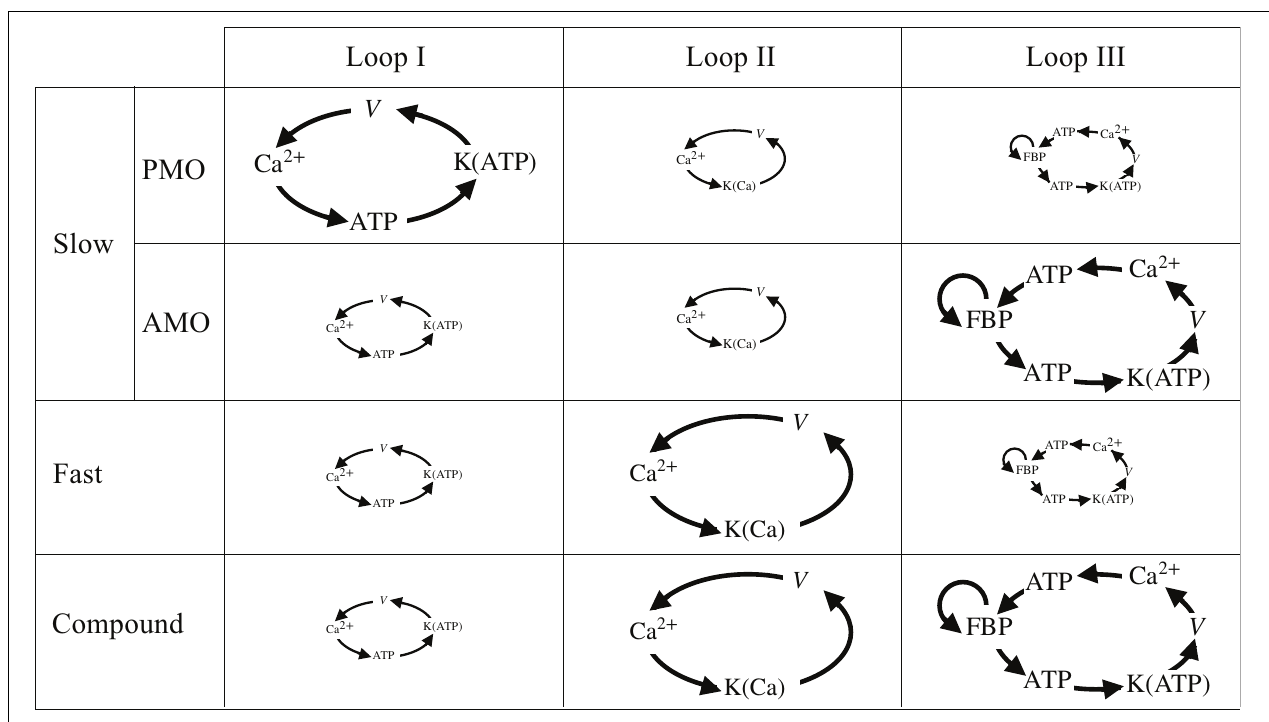
FIGURE 10 | Schematic of the three main loops encapsulating the symbiosis between metabolism and Ca 2 + activity. The size of each loop is proportional to the importance of its role played in slow, fast, and compound bursting. Note that slow bursting can be driven by two different mechanisms, loop I for PMOs or loop III for